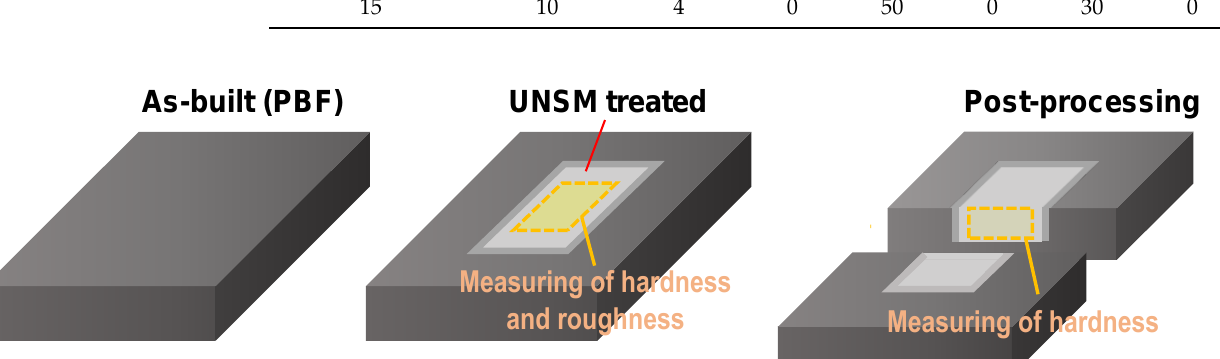
Figure 2. Experimental procedure for UNSM treatment on as-built specimen.